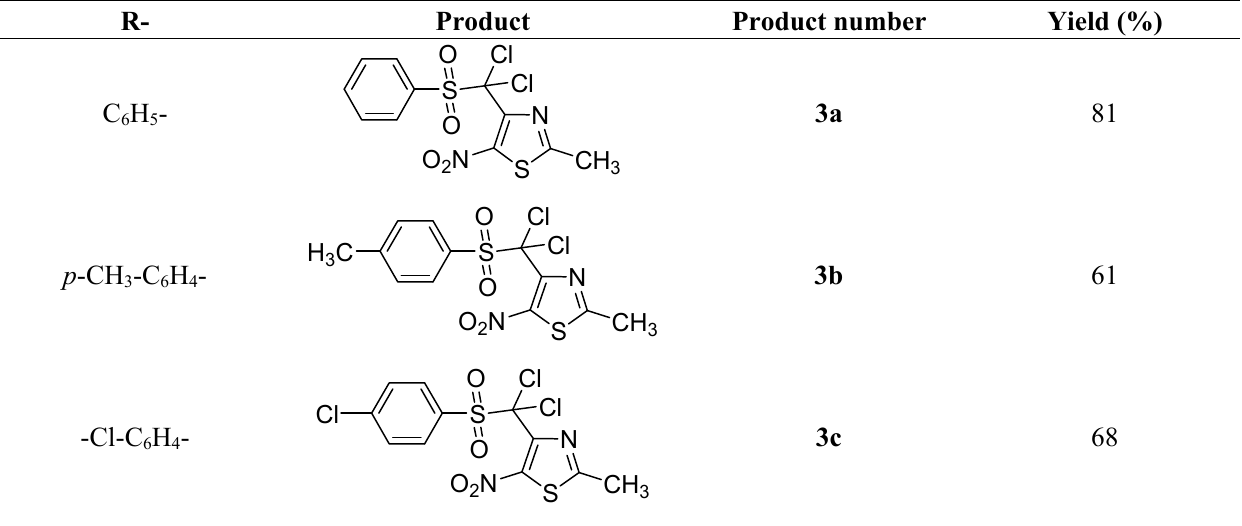
Table 3. Microwave-mediated preparation of dichlorinated sulfone